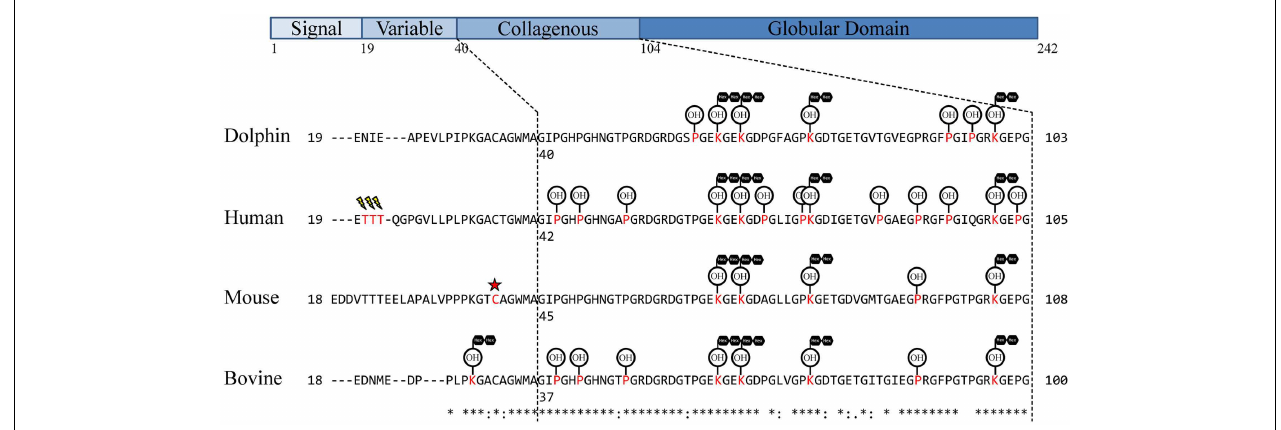
Assigned modifications for comparison are from previous studies of adiponectin in human (32, 35), mouse (30, 34, 37), and cow (31). Modified residues are in red, sialylation is represented as a lightning bolt, succination represented as a red star, hydroxylation represented as OH encircled, glycosylation [specifically, glucosyl- α (1,2)galactosylation] represented as black hexagons in